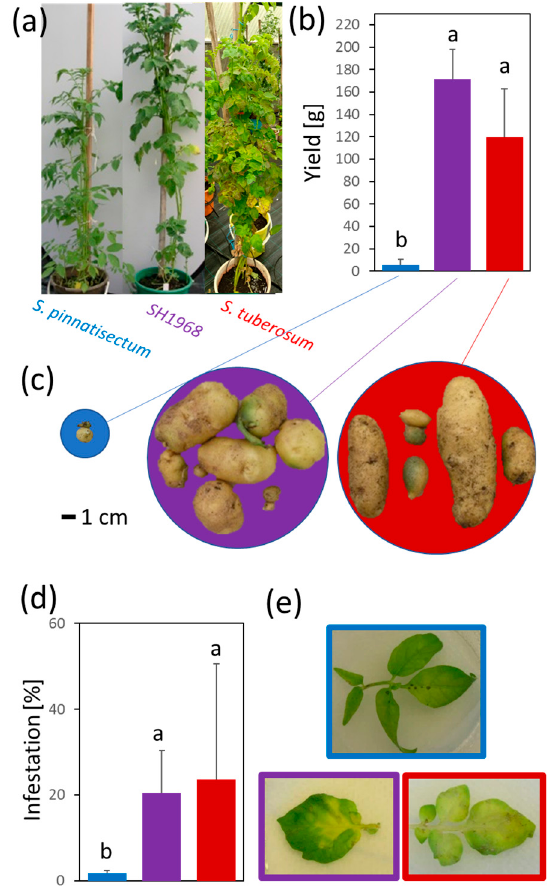
Figure 1. Solanum genotypes employed in the experiment. Representative images of 12 week old plants ( a ), comparison of yields (grams per plant) ( b ), representative images of tubers ( c ), and effects of Phytophthora infestans inoculation in the detached leaf experiment 96 hai ( d , e ). Parental genotypes Solanum pinnatisectum (blue), S. tuberosum cv. Kerkovske rohlicky (red), and somatic hybrid SH1968 (magenta). The plots represent the mean and standard deviation of four harvests ( b ) and five biological replicates ( d ). Different letters indicate significant differences (Kruskal–Wallis test, p < 0.05).